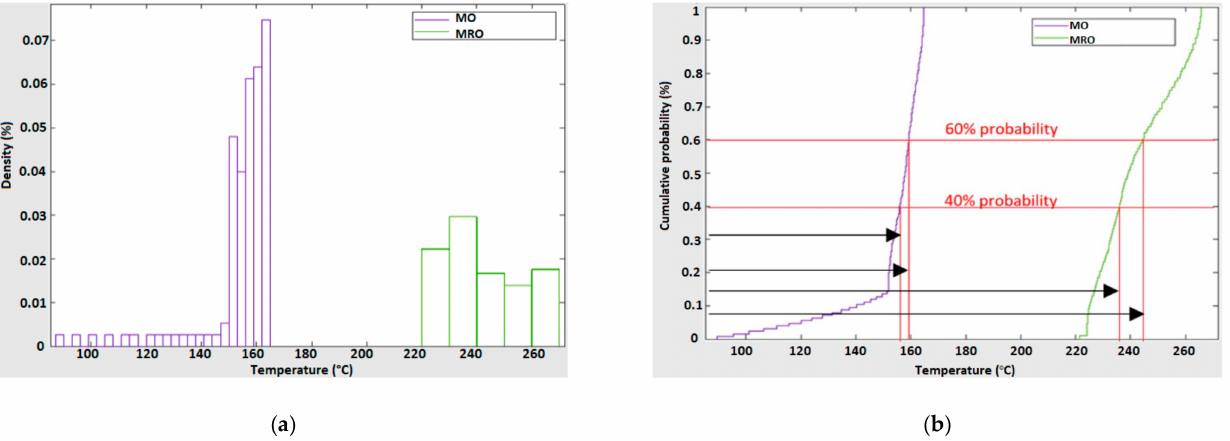
Figure 24. Distribution of data point of flash points of MRO and MO, ( a ) showing the % density plot, ( b ) showing the cumulative probability with survival rate between the range of 40–60% probability.